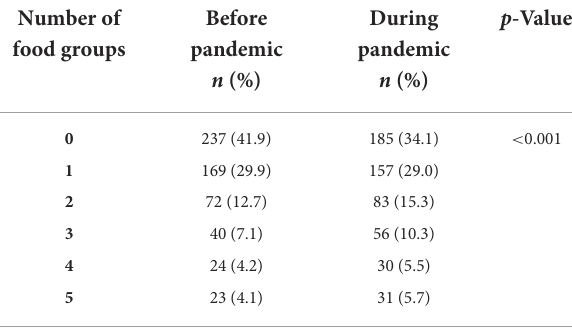
TABLE 4 Adherence to recommended number of food groups according to USDA. Number of food